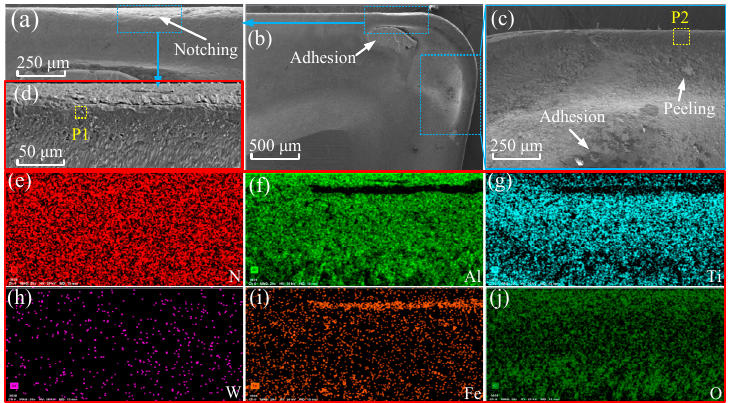
Figure 14. ( a – d ) The rake face wear of Tool B after 82 min of cutting. ( e – j ) Distribution of elements. The scan point is selected by selecting the more pronounced area of tool wear. By comparing the energy spectra of the corresponding points in Figures 15 and 16, the per- centage of the Fe and O of Tool A is higher, indicating that in the severe area of tool wear, the bonding wear and oxidation wear of Tool B are less significant.